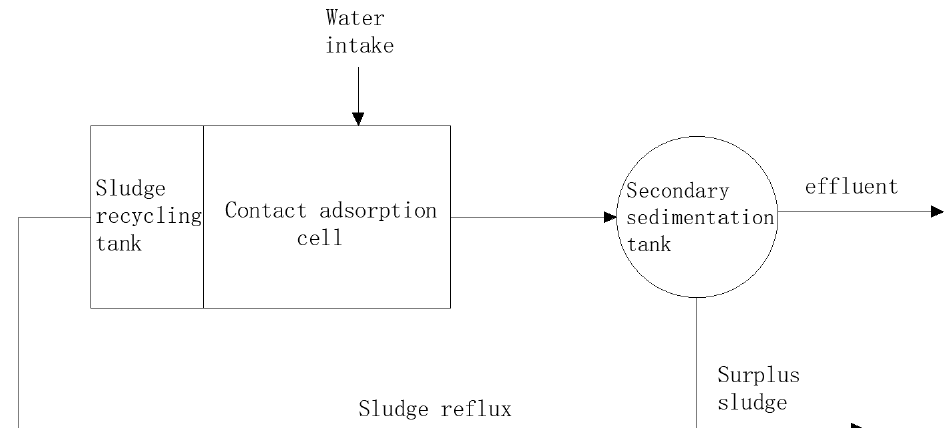
Figure 3. Process flow chart of adsorption-regeneration activated sludge method.